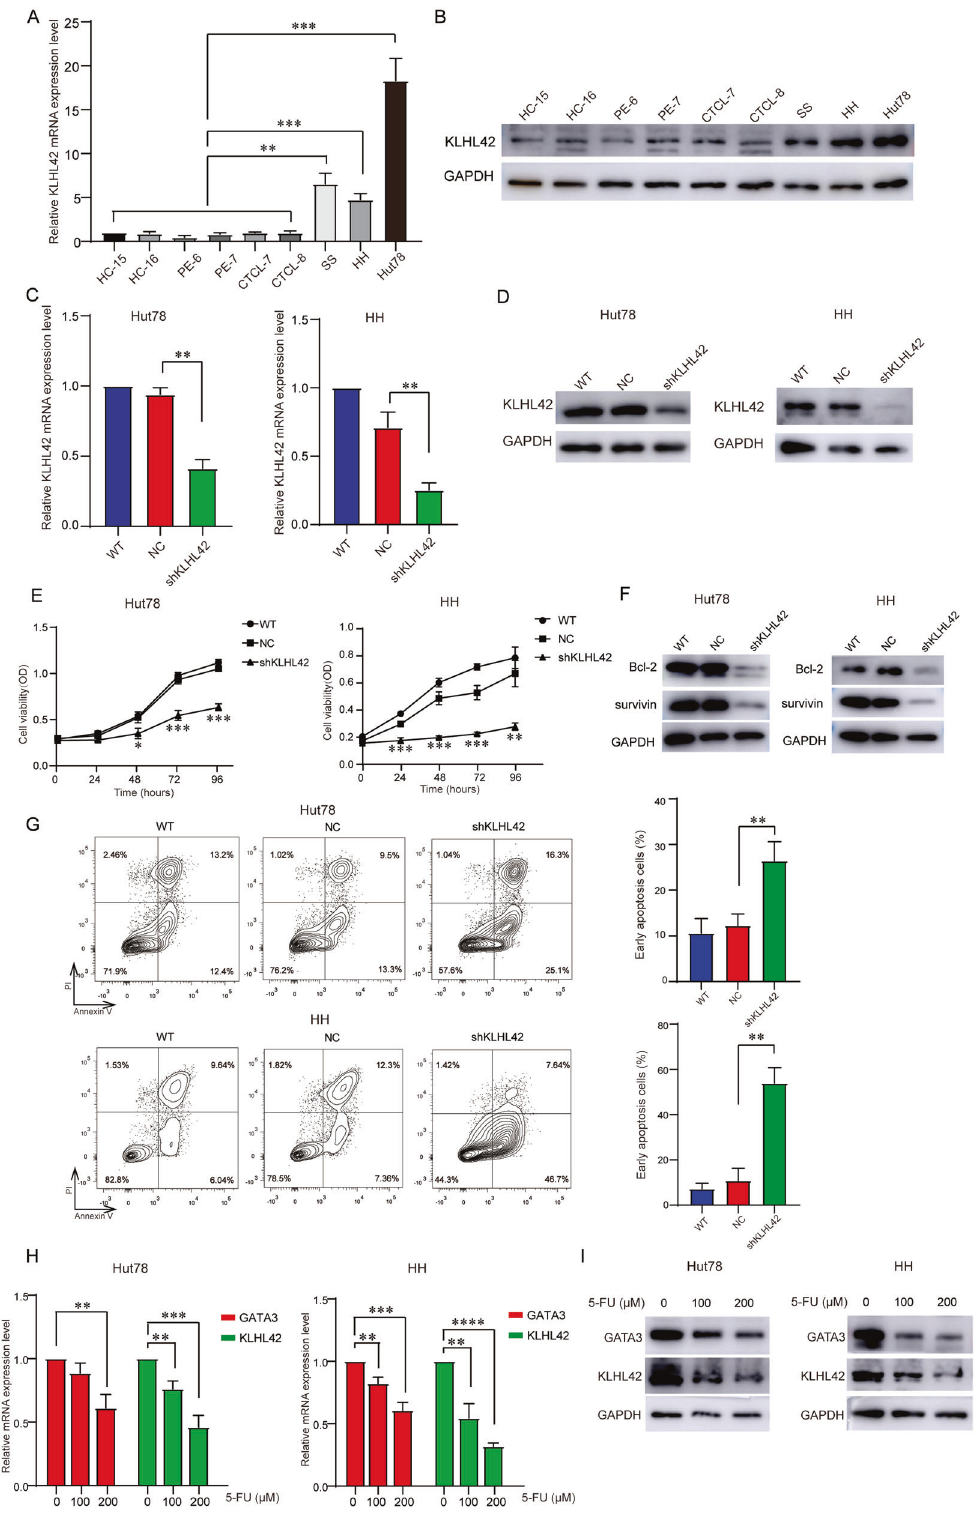
Fig. 6 KLHL42 knockdown inhibited CTCL cell proliferation and promoted its apoptosis in vitro. A , B The KLHL42 mRNA and protein expression of PBMC CD4 + T cells in two HCs, two PE patients, two advanced-stage MF patients and one SS patient as well as HH and Hut78 cells were measured by qRT-PCR ( A ) and western blotting ( B ). C , D Suppression of KLHL42 mRNA and protein expression in Hut78 and HH cells by lentiviral transduction with shRNA sequences. E CCK-8 proliferation assays in Hut78 and HH cells with or without KLHL42 silencing. F Western blotting analysis of anti-apoptosis proteins in Hut78 and HH cells with or without KLHL42 silencing. G Long-term culture of the transduced cells revealed an increase in the Annexin V + PI - (early apoptosis) population in KLHL42 -silenced cells compared with control cells. H , I 5-FU repressed GATA3 and KLHL42 expression in a dose-dependent manner. The mRNA and protein levels of both GATA3 and KLHL42 in Hut78 and HH cells were measured by qRT-PCR and western blotting. WT, wild type; NC, negative control. Data are presented as mean ± s.d. * P <0.05, ** P <0.01, *** P <0.001, **** P <0.0001. Cell Death and Disease (2022)